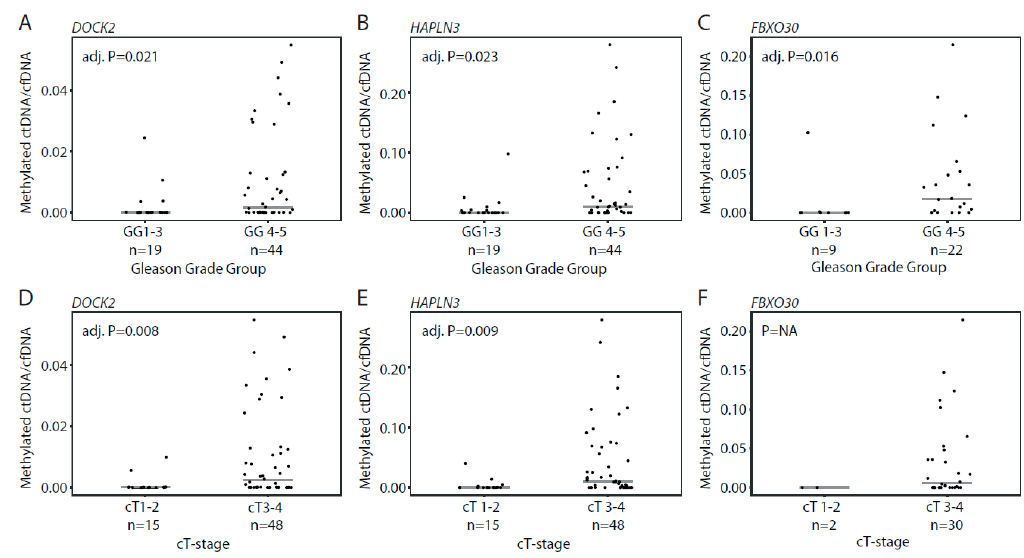
Figure 4. Association between methylated ctDNA fractions in plasma samples from patients with de novo mPCa and clinical parameters. Ratio between methylated ctDNA and cfDNA for DOCK2 and HAPLN3 in patients assigned to Gleason Grade group 1–3 vs. 4–5 ( A – C ) and clinical T-stage 1–2 vs. 3–4 ( D – F ). Bars indicate median values in each group. p -values were calculated with Mann–Whitney test. Adj. P, Benjamini–Hochberg adjusted p -value. GG, Gleason Grade Group. NA, not applicable.